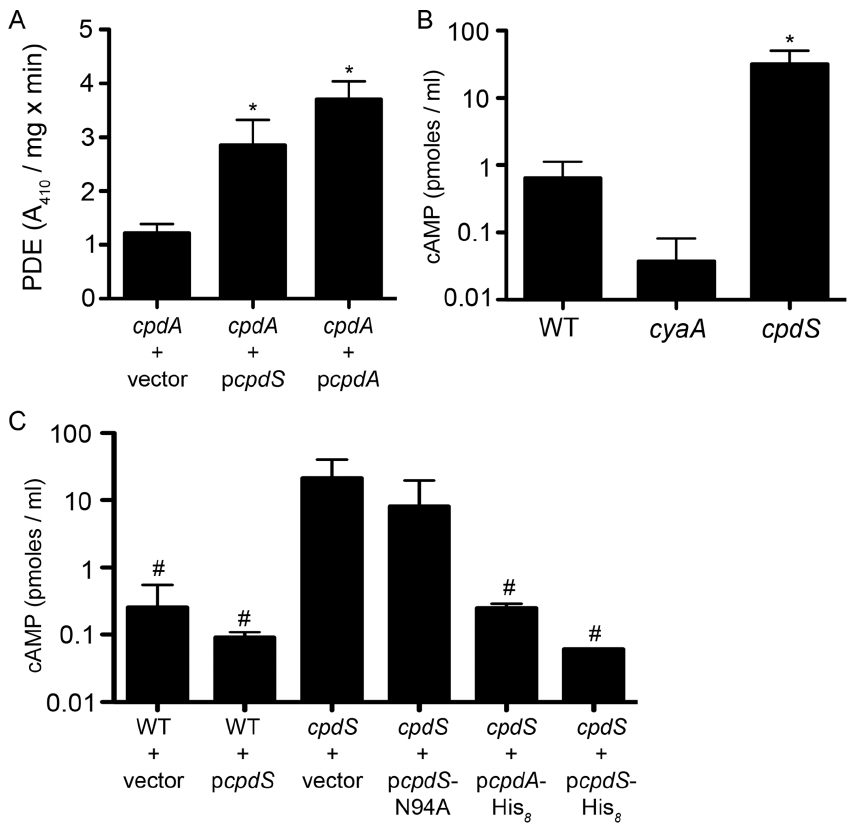
Figure 3. CpdS exhibits cAMP-PDE activity invivo . A. Phosphodiesterase activity measured from protein lysates of an E. coli cpdA mutant strain bearing the negative control empty vector (pMQ131), p cpdS (pMQ171), or positive control p cpdA (pEJK3). Bis- p NPP was used as a substrate to measure PDE activity. B–C. Intracellular cAMP levels measured using an EIA assay was measured from S. marcescens cells of the indicated genotypes. Vector = pMQ131, p cpdS = pMQ171, p cpdA = pEJK3, p cpdS -N94A = pMQ176, p cpdA -His 8 = pEJK7, p cpdS -His 8 = pMQ198. Asterisk indicates significant increase compared to cpdA + vector (A) or WT (B), p , 0.05 by ANOVA with Tukey’s post-test. The number sign indicates a significant reduction from cpdS + vector, p , 0.05 by ANOVA with Tukey’s